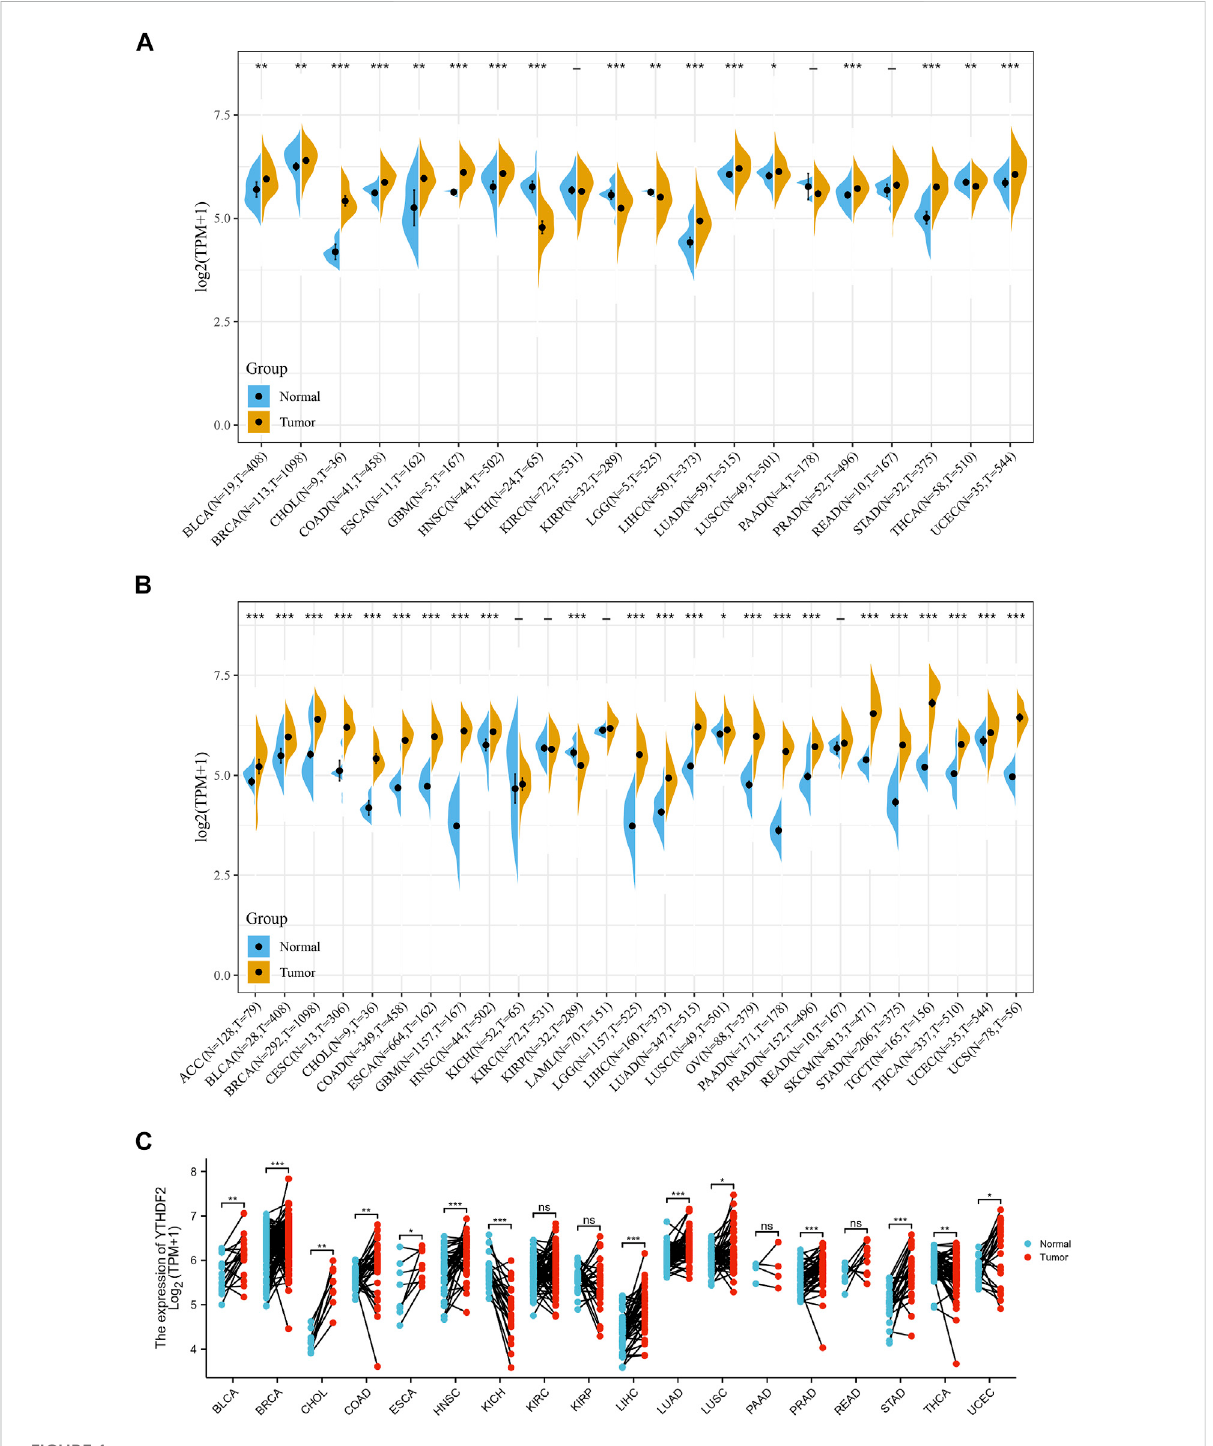
FIGURE 1 Differential expression of YTHDF2 across cancers. (A) The expression ofYTHDF2 intumor and adjacentnormal tissues using theTCGA data. (B) ThedifferentialexpressionofYTHDF2intumorandnormaltissuesof27cancertypesusingthecombineddataofTCGAandGTEx. (C) Theexpression of YTHDF2 in tumors and paired adjacent normal tissues. * p < 0.05, ** p < 0.01, *** p <